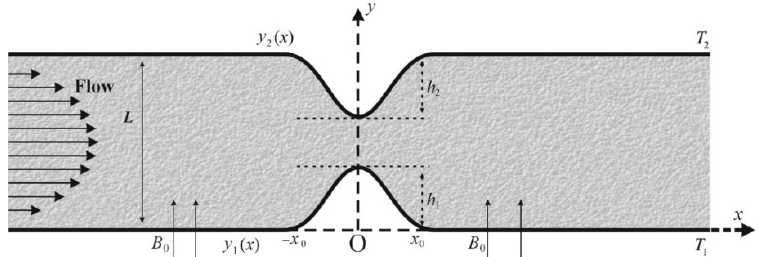
Figure 1. A schematic diagram of the flow channel with symmetrical constriction on both walls.